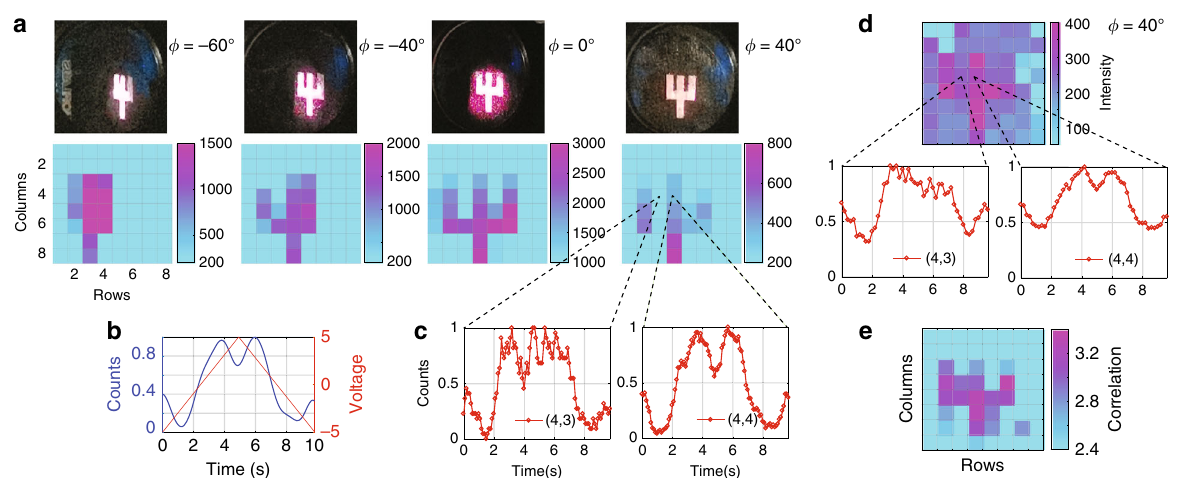
Fig. 4 Enhancing the contrast of an image. a The top and bottom row show the illuminated object (size 4 mm x 3.6 mm) – with the scattering surface rotated at four different angles φ 2 f(cid:2) 60 0 ; (cid:2) 40 0 ; 0 0 ; þ 40 0 g – and the corresponding images observed in the camera. Only the events detected during the 0.6 ns window – centered around the middle-peak – were post-selected to form the image. b The variation of counts (normalized) as a function of the applied phase-signature. This is the expected count pattern – the reference pattern – for high signal-to-noise ratio scenario. c The observed pattern in response to the phase-signature for two neighboring pixels (4,3) and (4,4) for rotation φ = 40 0 . d Image captured by the SPDA imager in the low-light and noisy environment. The observed pattern at the same two neighboring pixels (4,3) and (4,4) are also shown. e The image reconstructed by cross-correlating the observed pattern with the reference pattern (see text and Methods section for more